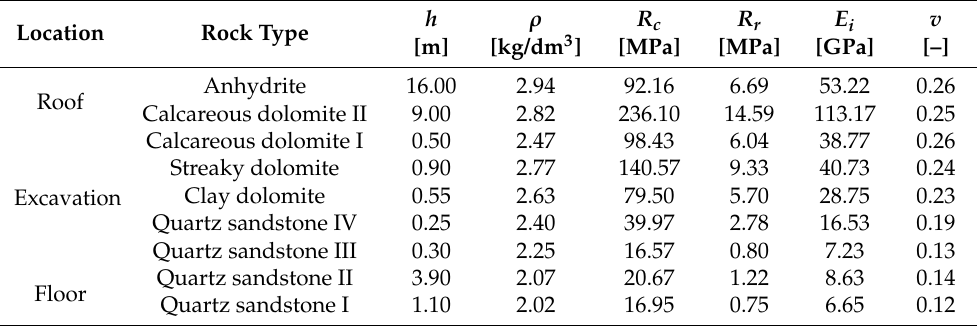
Table 2. Mean strength and strain rock parameters determined in laboratory tests for the Jm-06 To-1 borehole [26].